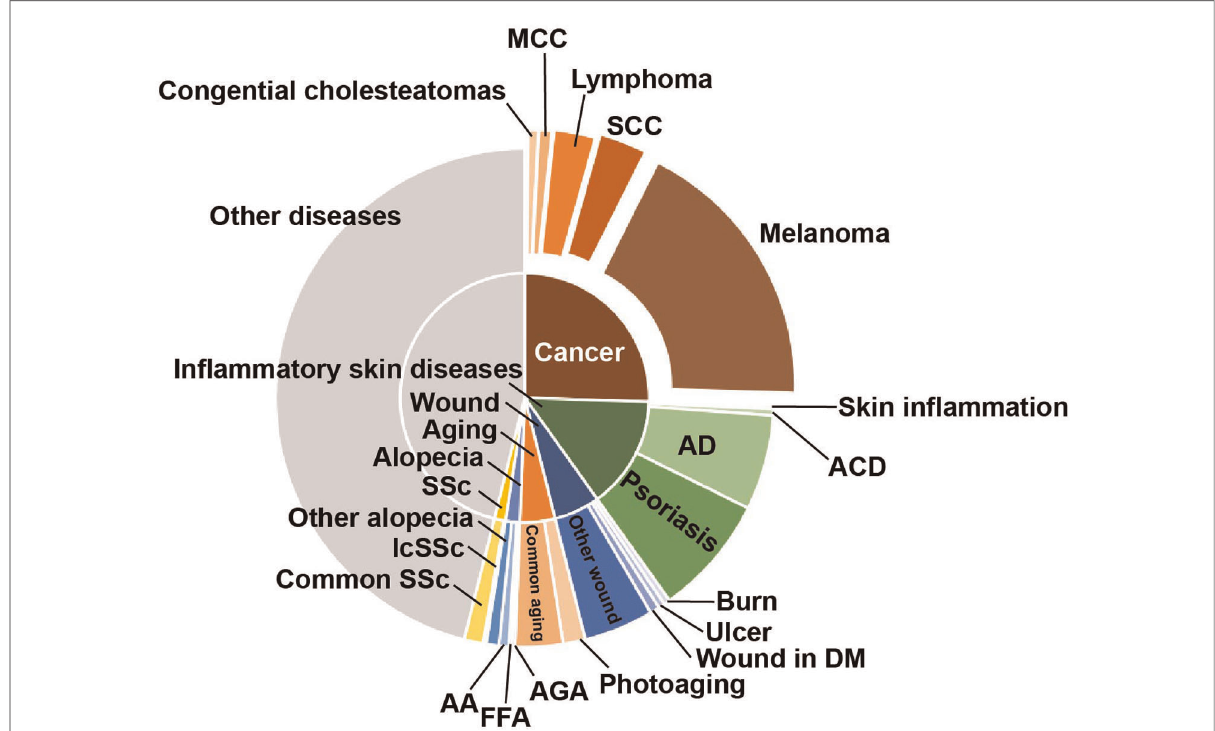
FIGURE 4 The proportion of research on the different skin diseases. The main application directions of proteomics are skin cancer and in fl ammatory skin diseases, among which melanoma, AD, and psoriasis are the main ones. SCC, squamous cell carcinoma; MCC, Merkel cell carcinoma; AD, atopic dermatitis; ACD, atopic contact dermatitis; DM, diabetes mellitus; FFA, frontal fi brosing alopecia; AA, alopecia areata; AGA, androgenetic alopecia; SSc, systemic sclerosis; lcSSc, limited cutaneous